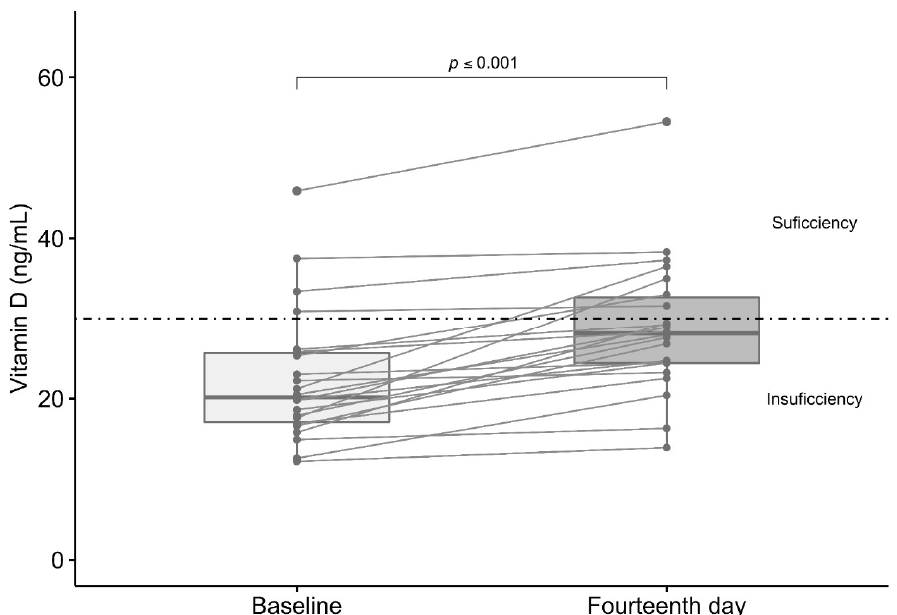
Figure 2. Effect of vitamin D3 supplementation in total serum levels of vitamin D. The light gray color bar shows baseline serum total vitamin D levels in COVID-19 outpatients ( n = 20) and the dark gray color bar shows total vitamin D levels in these same patients on the fourteenth day after supplementation with 10,000 IU daily of vitamin D3. Comparisons among groups were made using the Wilcoxon Rank-Sum Test.